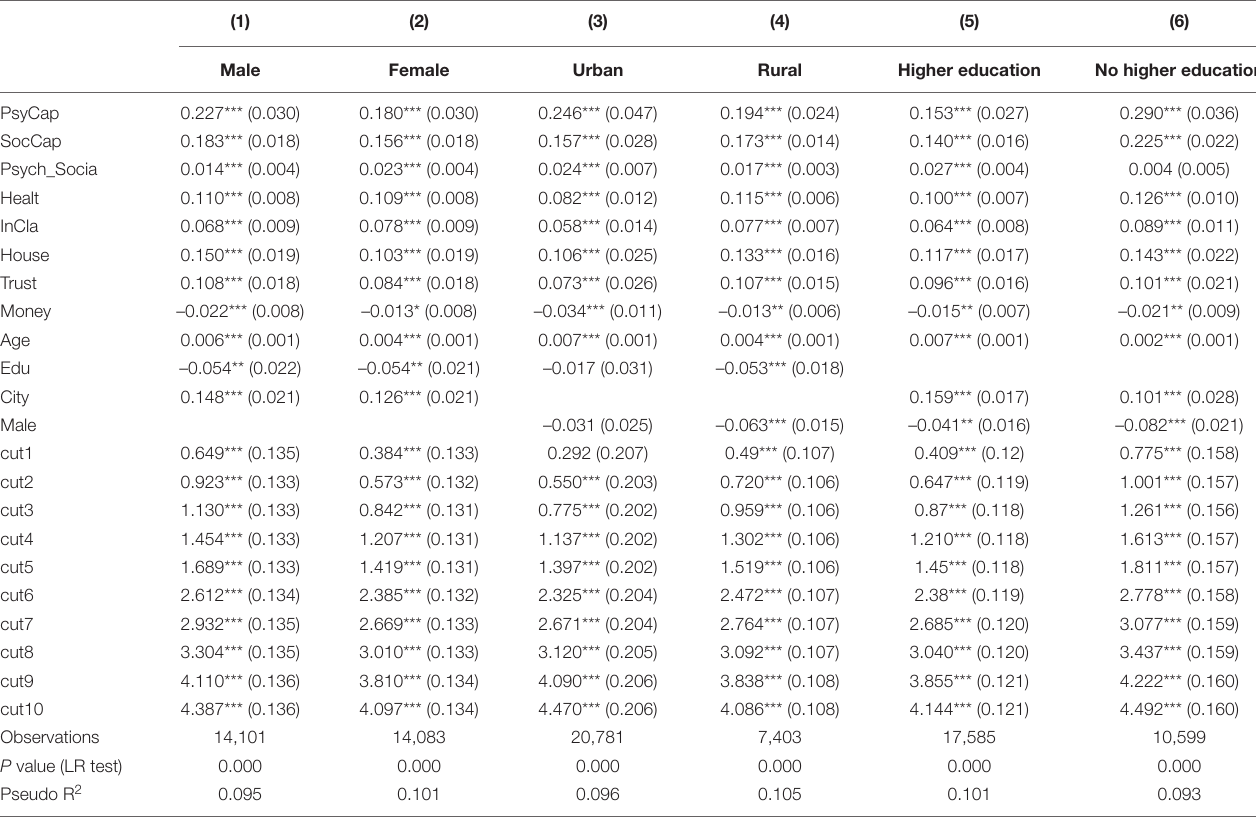
TABLE 7 | Results of the heterogeneity